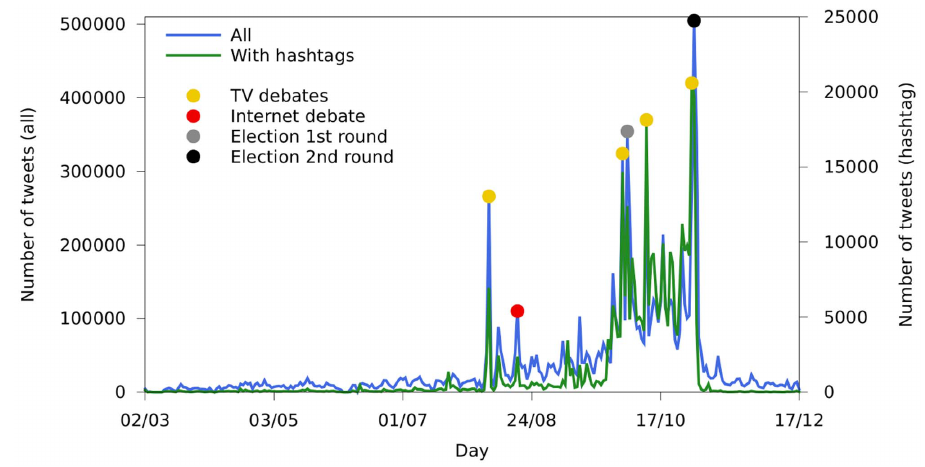
Figure 1. Evolution of the activity related to the 2010 Brazilian elections on Twitter.